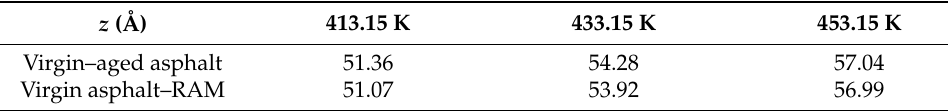
Table 3. Diffusion region length of virgin asphalt–RAM.